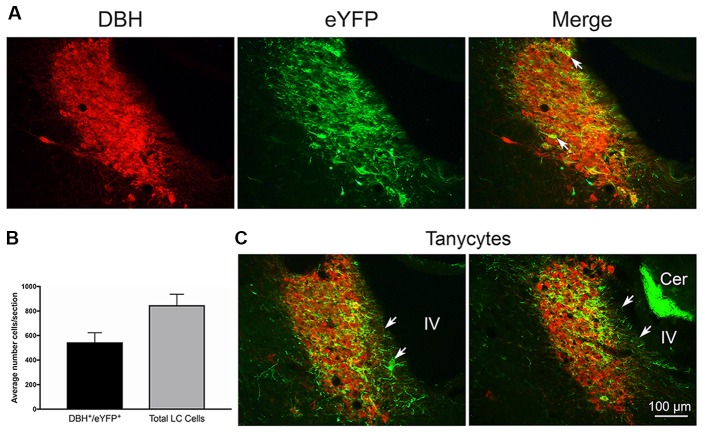
(A) Left: dopamine-β-hydroxylase (DBH) staining of locus coeruleus (LC) neurons. Middle: enhanced yellow fluorescent protein (eYFP) expression in TH:Cre LC neurons. Right: merge image of both markers. Arrow indicates an example of occlusion of DBH staining by strong eYFP expression in a TH:Cre neuron. (B) Graph of average co-localization of the channel expression marker eYFP+ in LC neurons sampled in three LC sections from 19 rats. (C) Coronal LC sections from two rats illustrating eYFP+ expression in putative tanycyte cells and processes at the medial ventricular non-neuronal LC margin. White arrows indicate tanycyte exemplars. Note another example of medial eYFP+ cells and processes in the merge panel in (A) under the white arrow stem. Cer = cerebellum with autofluorescing granule cells. IV = adjacent 4th ventricle.